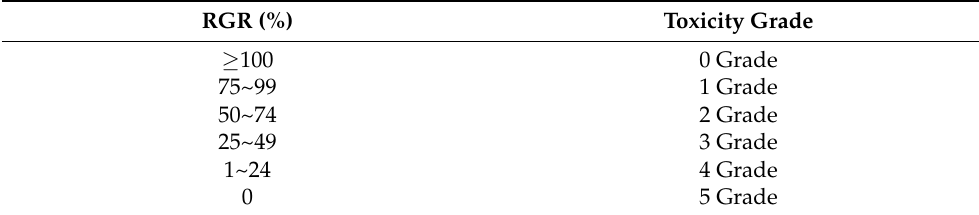
Table 1. Relative growth rate (RGR) and cytotoxicity grade